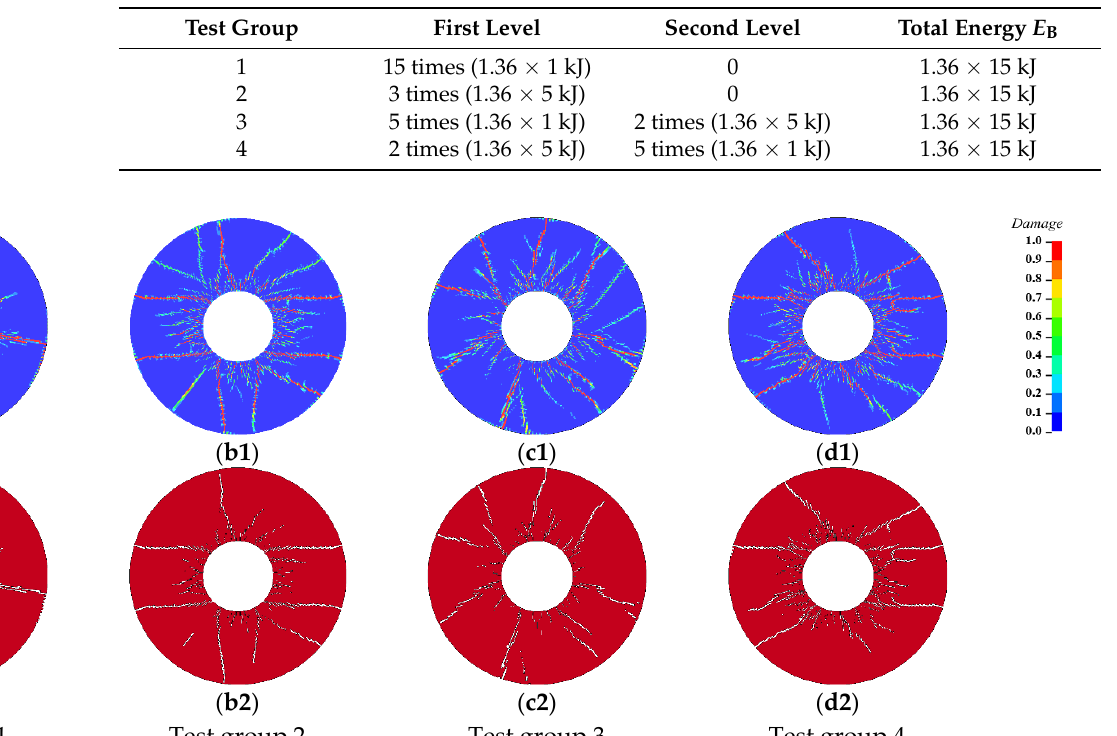
Figure 17. Variation of fracture density under different discharge energies when P c = 1 MPa and P h = 0 MPa.